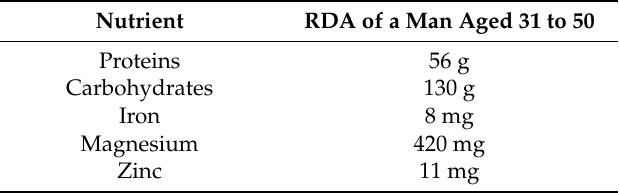
Table 4. Recommended Dietary Allowance (RDA) of selected nutrients required daily by men aged 31–50 years